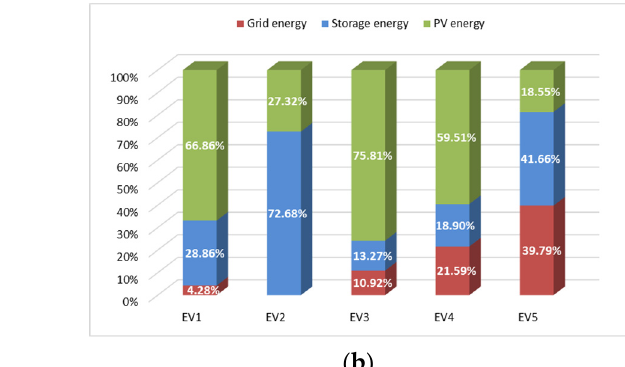
Figure 12. ( a ) Energy system distribution and ( b ) energy system cost — case 2.